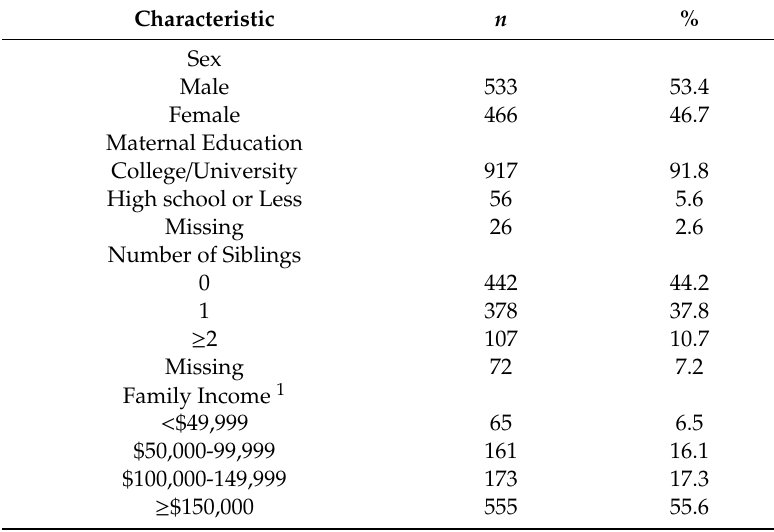
Table 1. Baseline characteristics of children from the TARGet Kids cohort with a visit at both ≤ 2.5 years old and 5–9 years old ( n =